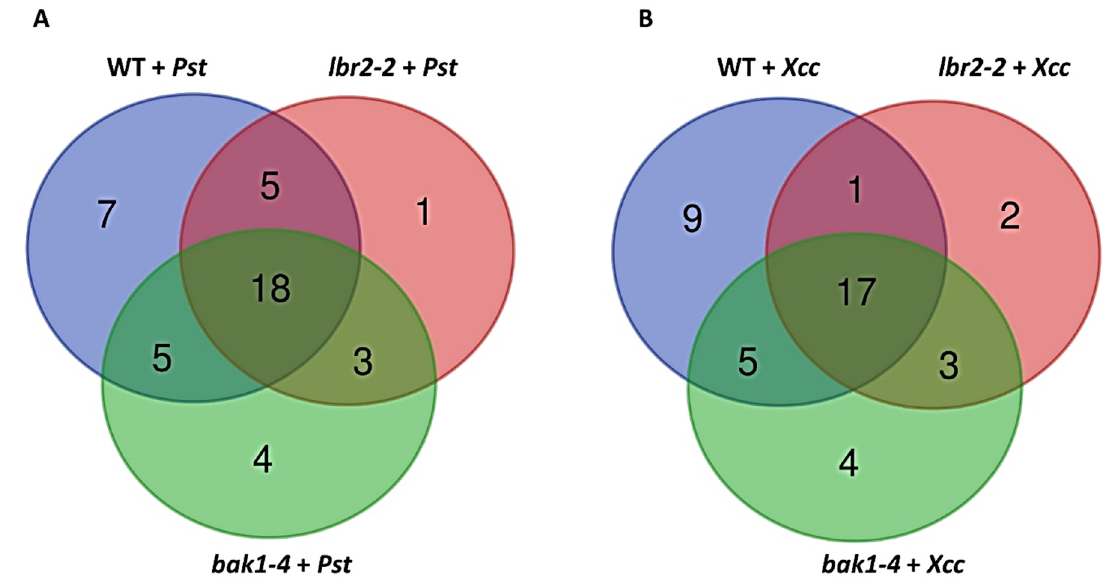
Figure 4. Venn diagrams of statistically significant annotated metabolites in LPS-induced Arabidopsis. ( A ) represents metabolites accumulated in the LPS Pst -treated Arabidopsis WT, lbr2-2 and bak1-4 . ( B ) represents metabolites accumulated in the LPS Xcc -treated Arabidopsis WT, lbr2-2 and bak1-4 . Diagrams show discriminatory metabolites (Table 1) that are shared and/or distinct after different LPS chemotype treatments.